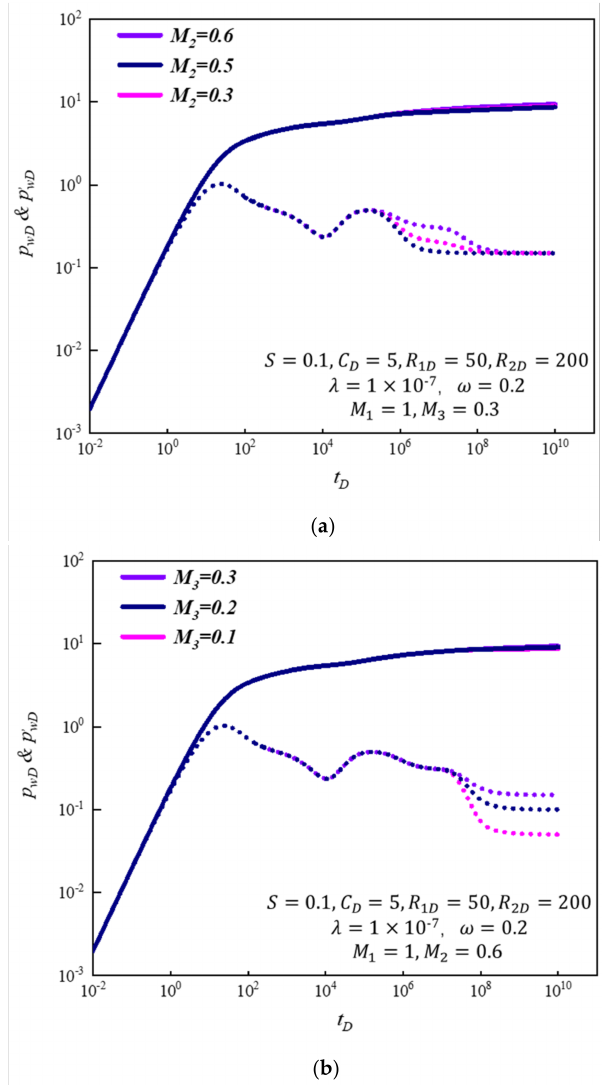
Figure 4. The comparison of type curves under a different mobility ratio Mi : ( a ) zone I and zone II; ( b ) zone II and zone